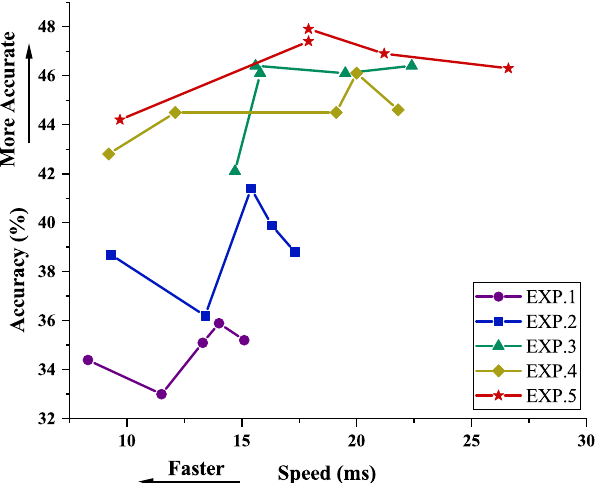
Figure 10. The ablation study of different network depths. The results are from Pascal VOC → Clipart. The image scale has been fixed at 640 pixels, and we evaluated the accuracy and speed of different depth networks.